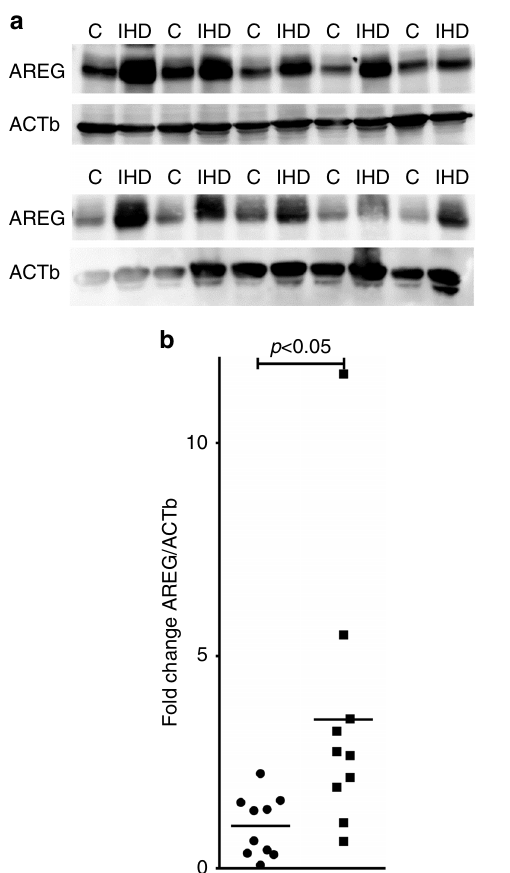
Fig. 4 Cardiac amphiregulin protein levels in myocardial tissues from healthy controls or patients with ischemic heart disease (IHD). a Amphiregulin (AREG) protein levels were determined by immunoblot after total protein isolation from control, healthy myocardial tissue (labeled C), or samples from patients with ischemic heart disease (labeled IHD). β - Actin (ACTb) served as a loading control. b Quanti fi cation by densitometry